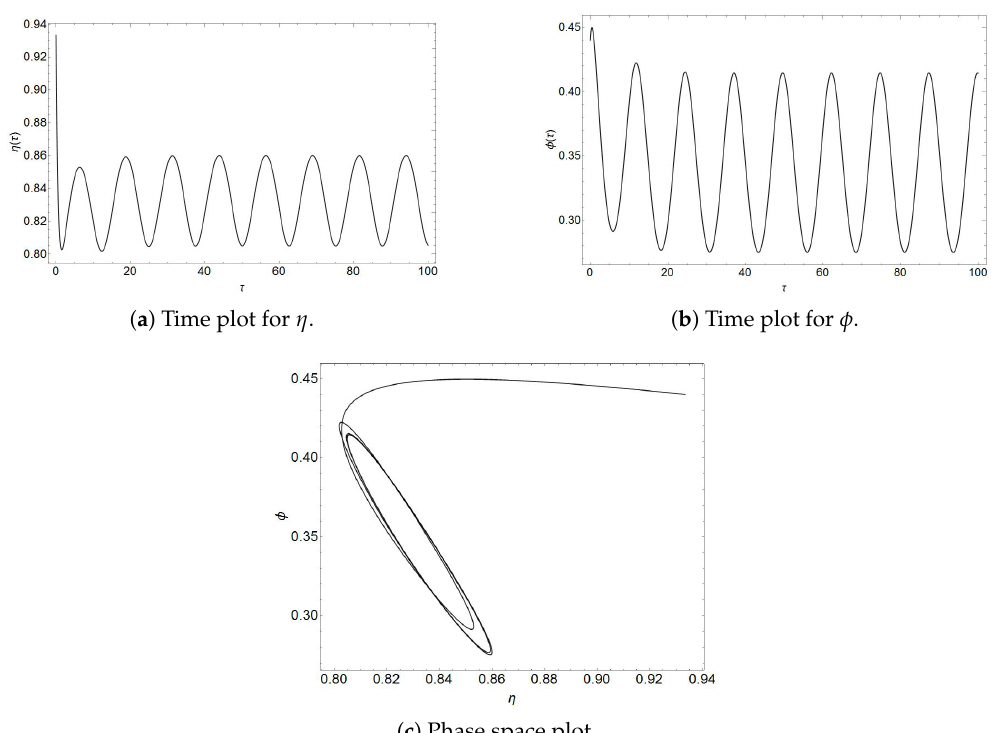
Figure 4. Plots for the Q-Switching technique with initial conditions η ( 0 ) = 0.93 and φ ( 0 ) =